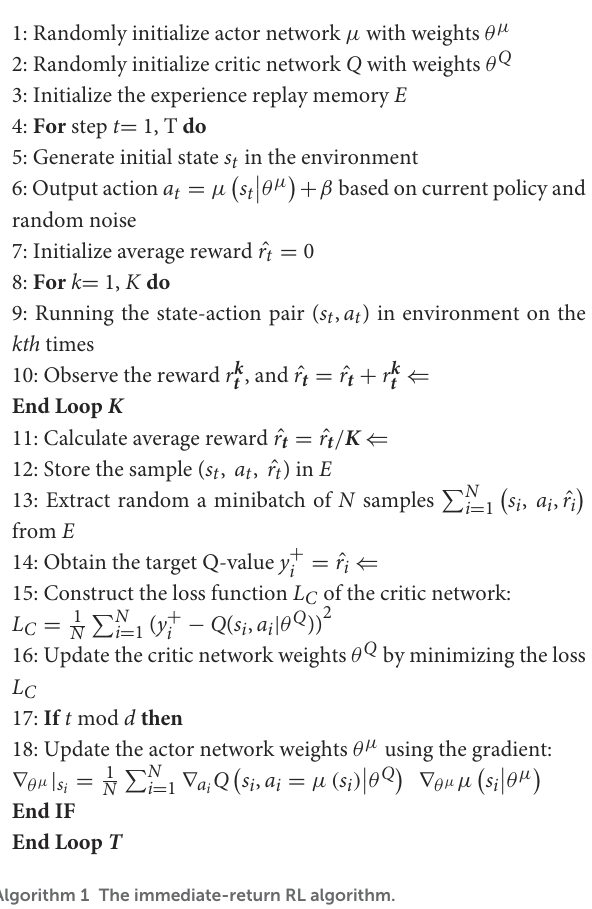
Algorithm 1 The immediate-return RL